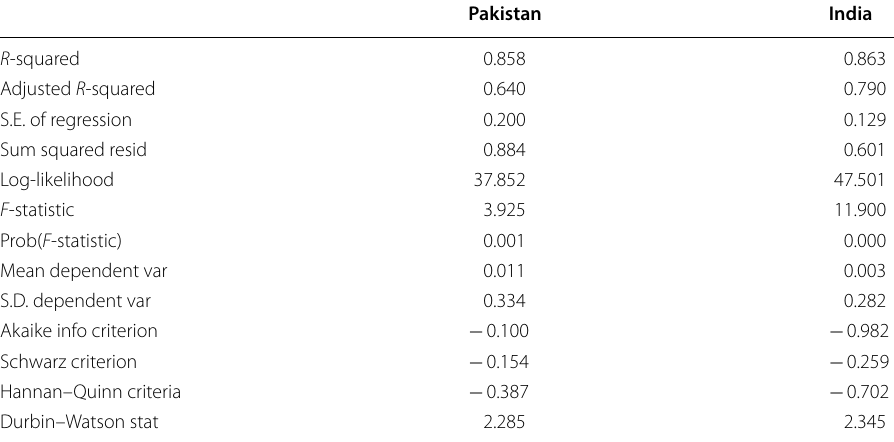
Table 6 Test to check auto correlation and heteroskedasticity